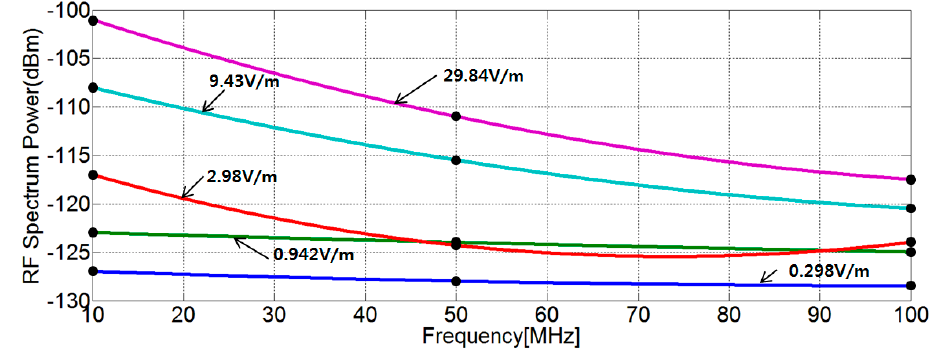
Figure 10. The photo-detected signal power versus frequency at different electric-field strengths in the TEM cell.